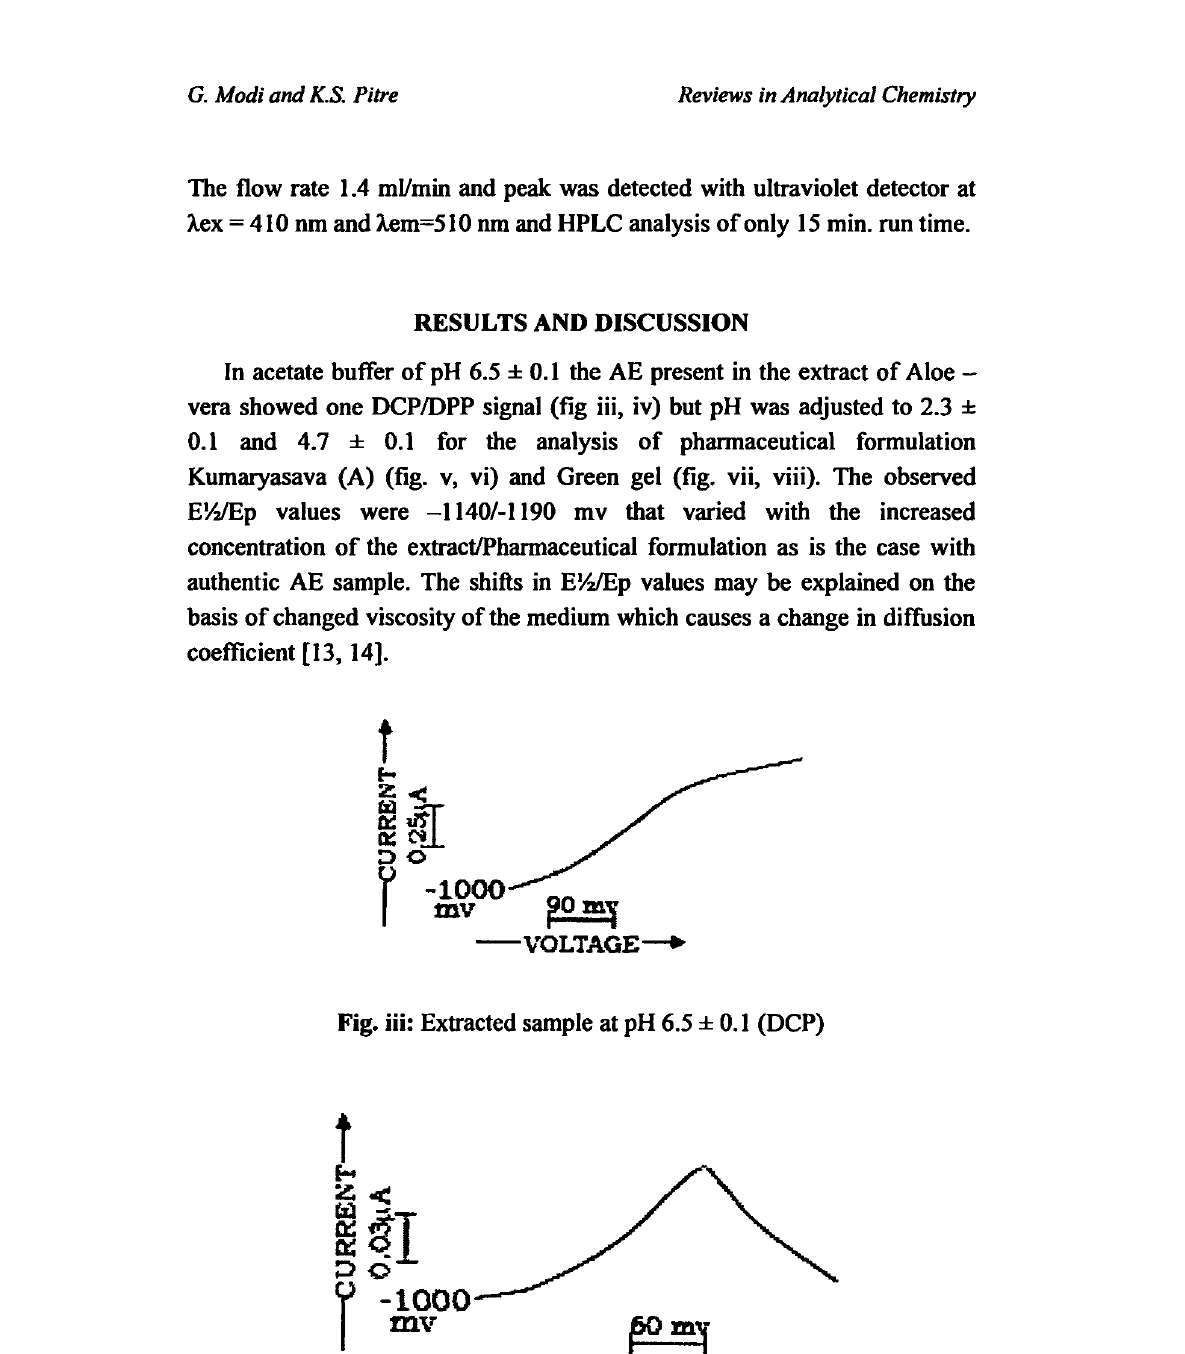
Fig. iv: Extracted sample at pH 6.5 ± 0.1